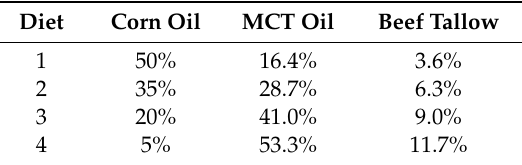
Table 4. This table shows the dietary fat composition of each of the four experimental diets fed to